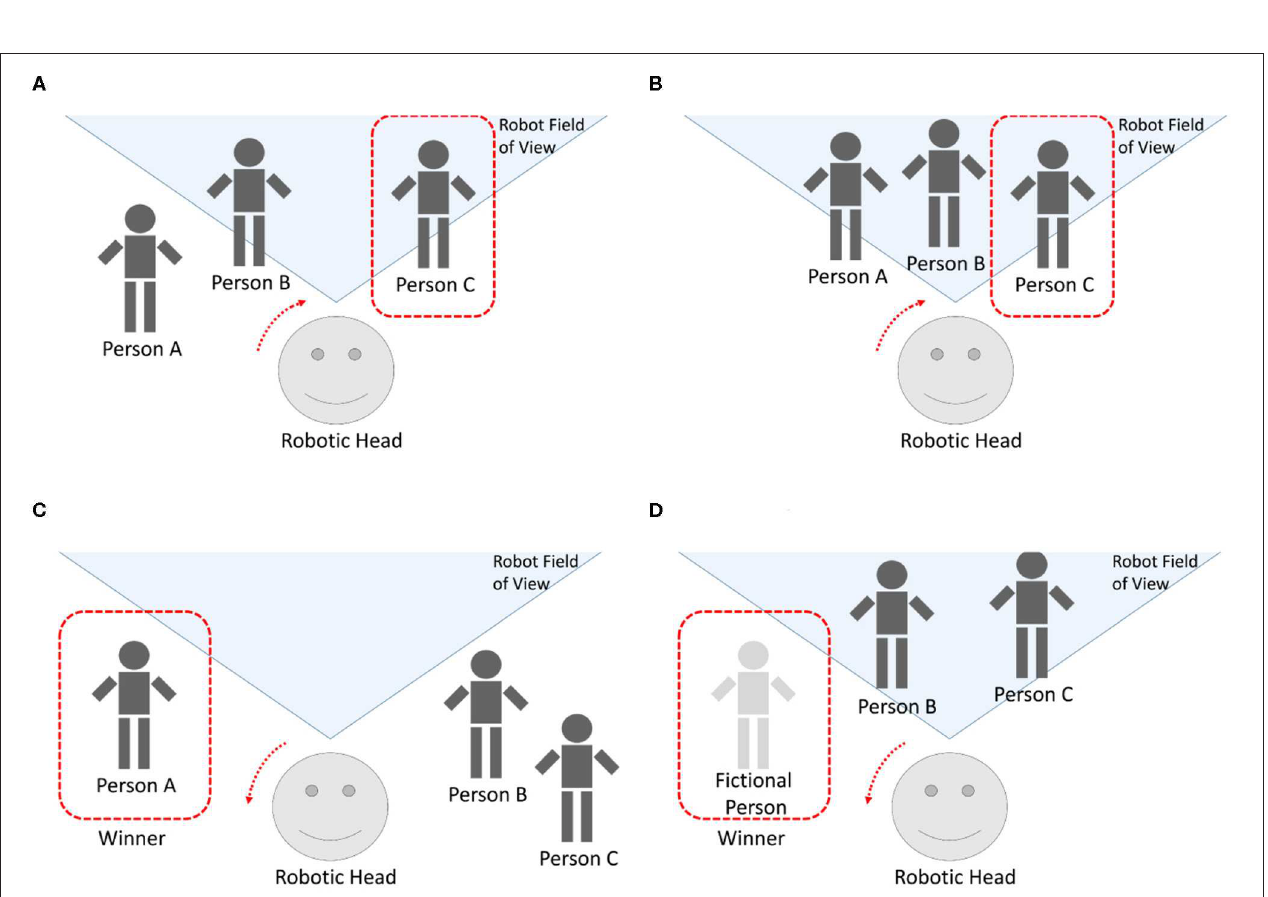
FIGURE 11 | Different situations interacting with the robotic head. (A) Three people in the FOV. (B) Two people in the FOV. (C) Nobody in the FOV. (D) A new person appear on scene.